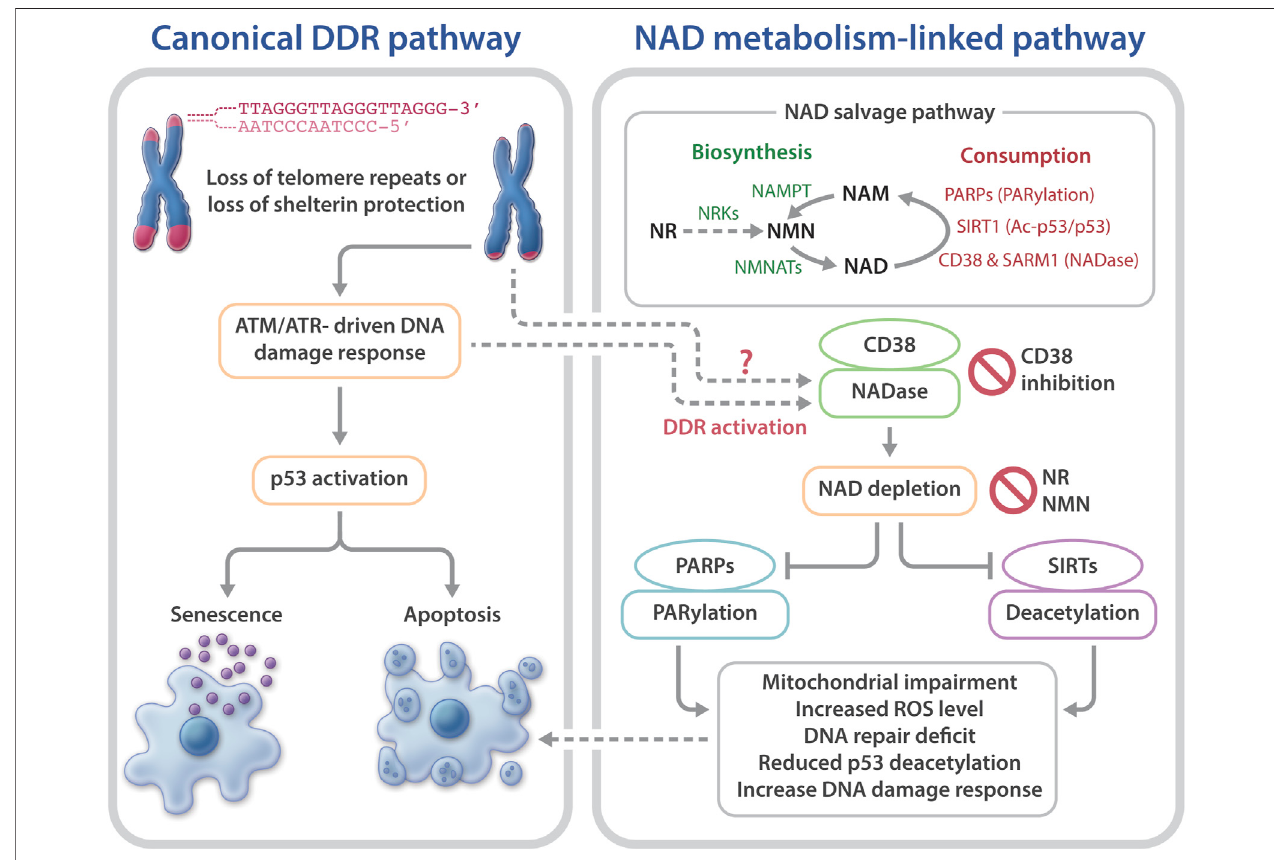
FIGURE 1| Telomeredysfunction-induced DNA damage response and NAD metabolism in telomeropathies. Telomeredysfunction via loss of telomere repeats or loss of protection by telomeric shelterin proteins elicits DDR, driving cellular senescence or apoptosis. Short telomeres and DDR also evoke NAD metabolome dysregulation,viaCD38hyperactivation, whichexcessivelyconsumesNADandreducestheavailableNADtoPARPsand SIRTs.Asaresult, thefunctionsofPARylation and SIRT1 activities in telomere and mitochondrial maintenance are limited. Consequently, mitochondrial impairment-induced ROS and defective PARP-related DNArepair mayacceleratetelomeredamageandaggravatecellular senescence orapoptosis.Topright: anoverviewoftheNADsalvagepathway. TheNADconsuming enzymes, PARPs, SIRTs, and NADases consume NAD and generate NAM. The NAD biosynthesizing enzyme nicotinamide/nicotinic acid mononucleotide adenylyltransferase (NMNAT) recycles NAM into NMN, followed by conversion of NMN to NAD by nicotinamide mononucleotide (NAMPT). The NAD precursor, NR is converted to NMN by NRKs nicotinamide riboside kinases.